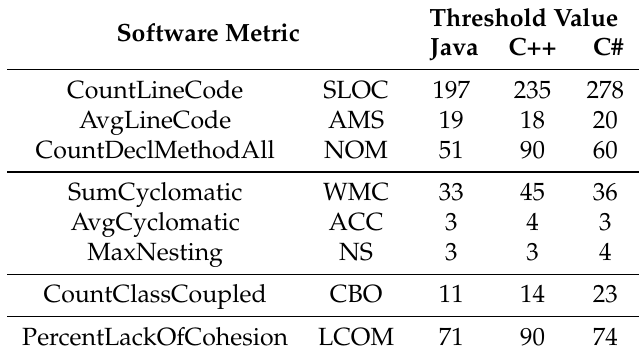
Table 1. Derived threshold values of selected software metrics grouped into quality